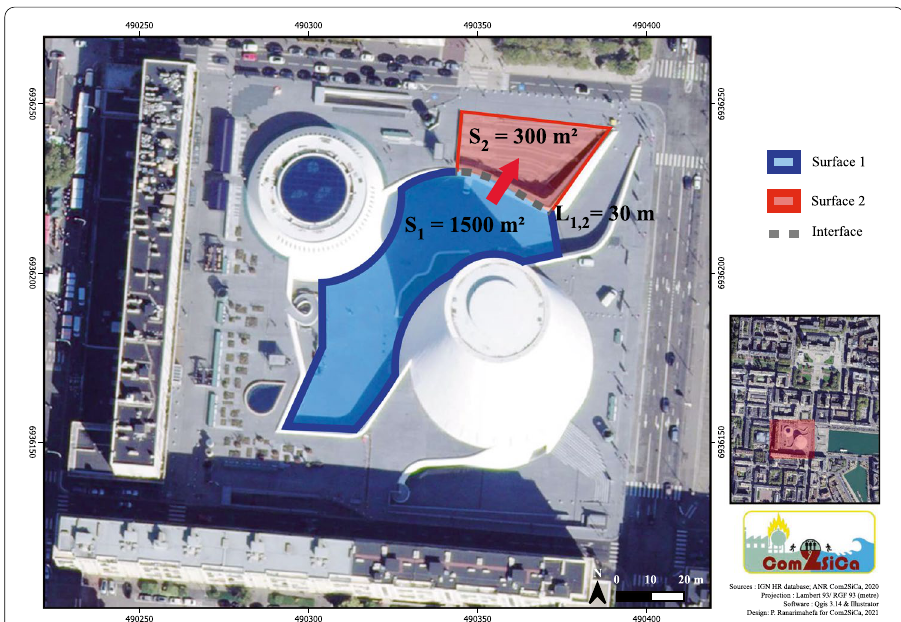
Fig. 7 Example of two nodes. Each node has a surface: here, the first node (in blue) has a surface of S 1 = 1500m 2 , while the second one (represented in red) has a surface of S 2 = 300 m 2 . Moreover, the two nodes are adjacent, and the exit from one node to the other is equal here to L = 30 m. This geographical information is useful to calculate the coupling coefficients